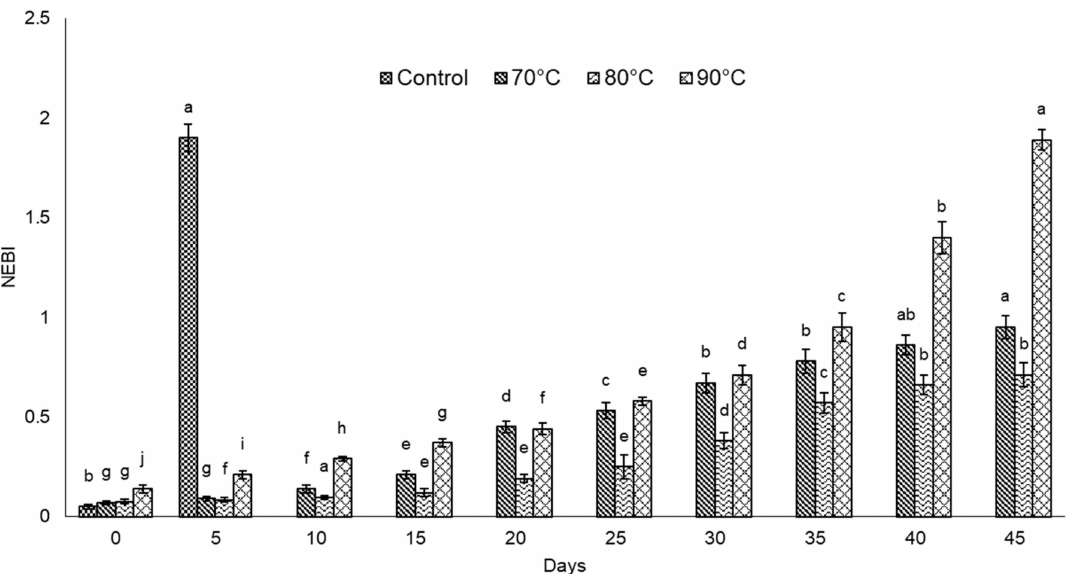
Figure 5. Non-enzymatic browning index (NEBI) of tomato-based pineapple beverage samples thermally treated at 70, 80, and 90 ◦ C during storage. Different lower-case alphabets represents significant difference in the values at different storage period.